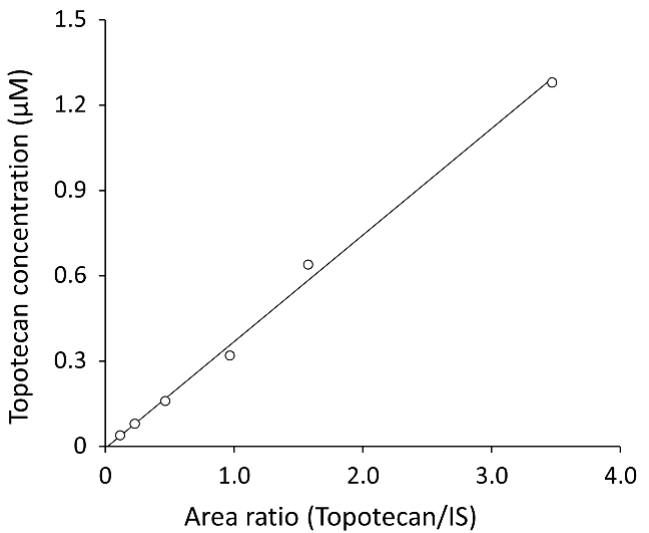
Figure 5. Topotecan calibration curve. A series of calibration samples were prepared using 0.04, 0.08, 0.16, 0.32, 0.64, and 1.28 µM topotecan in the CSF.